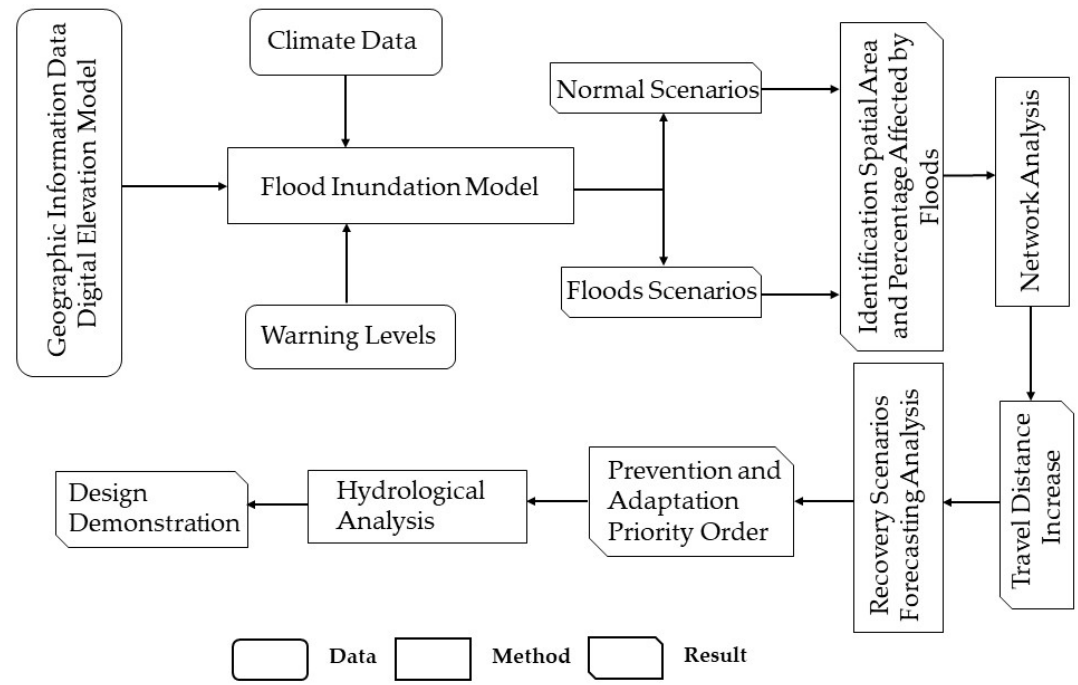
Figure 1. Research Figure 1. Research framework.